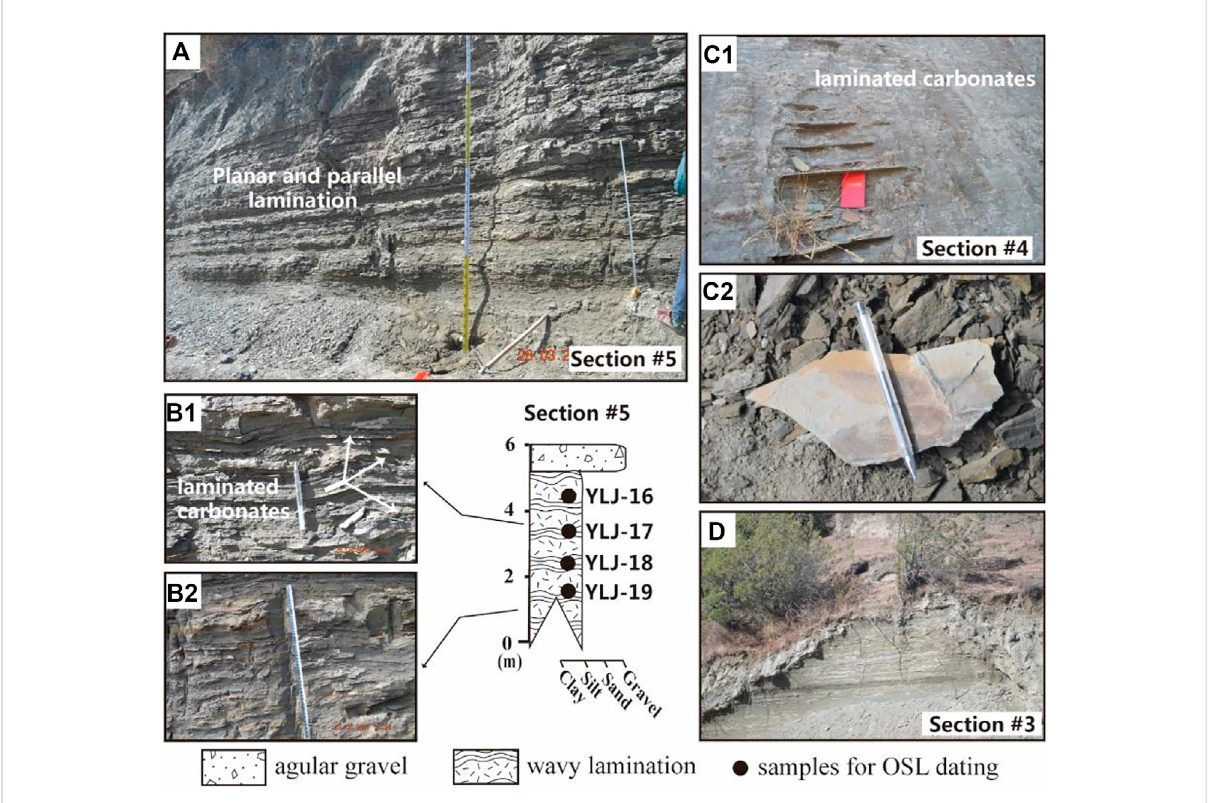
FIGURE 4 Detailed sedimentary logs and photographs of lacustrine section #5 at the Yuting landslide-dammed lake. Solid black circles and YLJ symbols represent the depth and number ofOSL dating samples. (A) Intact exposure of section #5.Planar and parallel laminations dominate the sedimentary characteristics. (B1,B2) Close-up photographs of the calcareous plate and wavy lamination. (C1,C2) Massive carbonate unit. (D) Lacustrine deposits in section